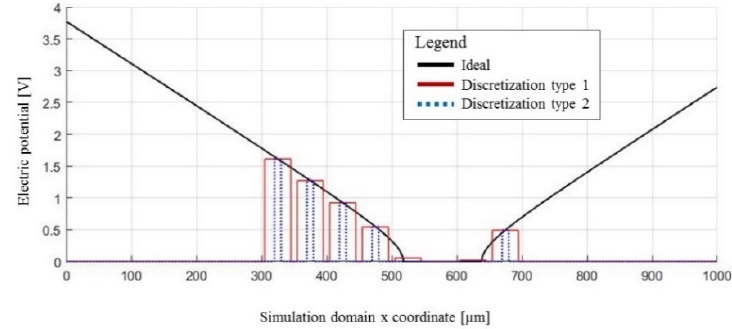
Figure 6. Computed electric potential values used for the top boundary condition.